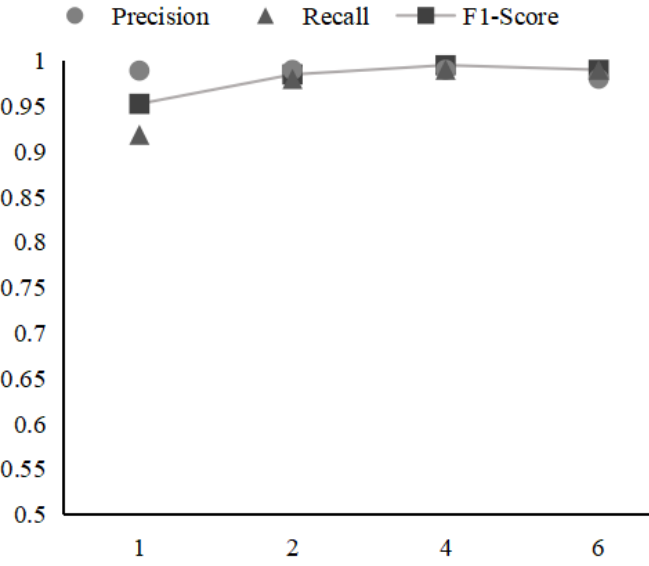
Figure 7. The impact of n-layer on the performance of